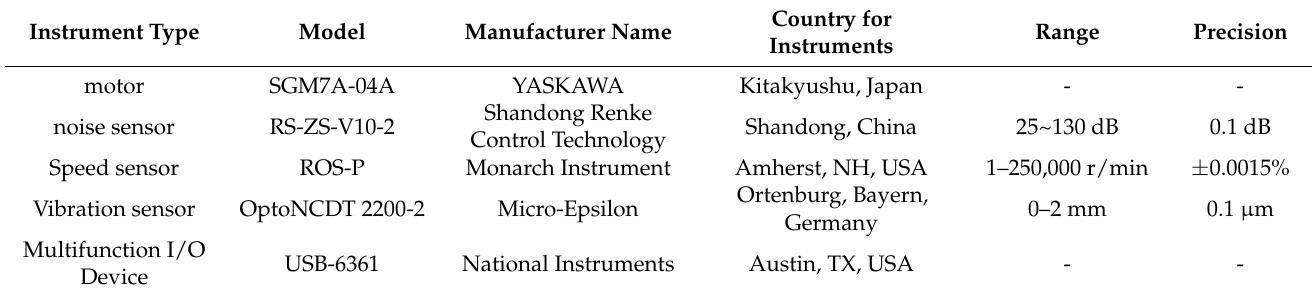
Table 1. The multi-functional spindle detection